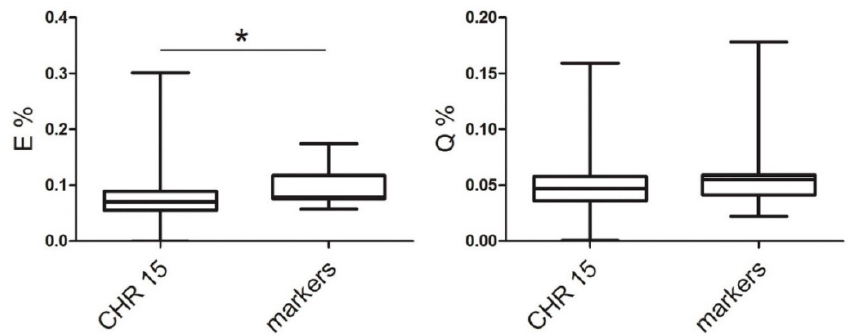
Figure 3. The content of glutamate and glutamine of protein codified by chromosome 15 and markers of dyslexia. Box plots of values for proteins of each group. Bottoms and tops of the boxes are the 25th and 75th percentiles, respectively; the lines across the boxes are the median values, the ends of the whiskers represent minimum and maximum values. * p < 0.05.